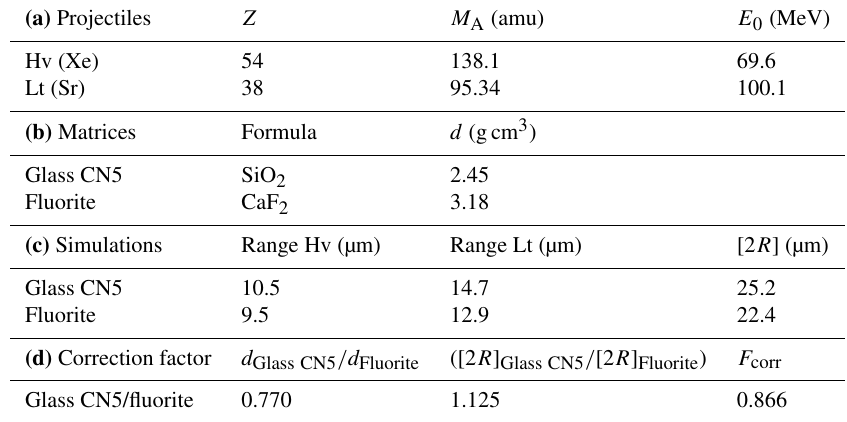
Table A1. Data used to calculate the correction factor for U concentration in fluorite using induced fission-track mapping in SRIM ®